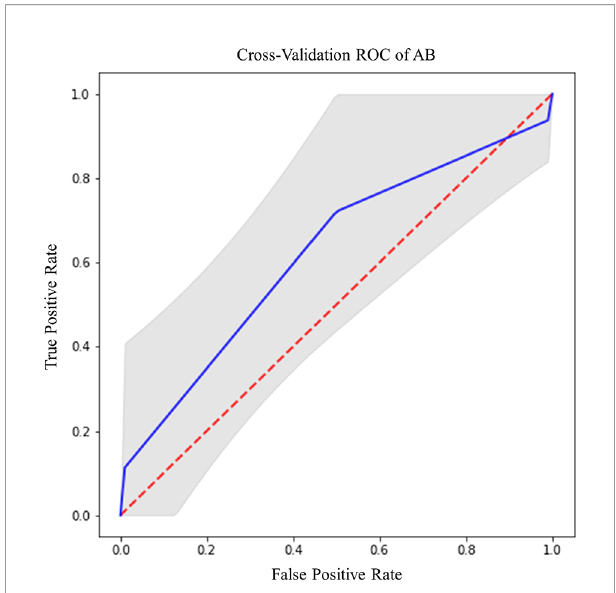
FIGURE 6 | Best ROC curve for KI67 prediction: AB classi fi er with ADC sequence on CET